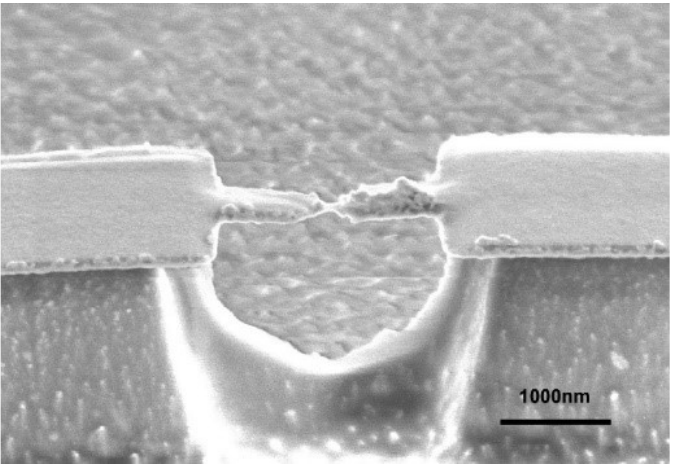
Figure 1. Scanning electron micrograph of a microfabricated mechanically controllable break junction (MCBJ) consisting of a free-standing Au junction on a polyimide-coated phosphor-bronze substrate. Scale bar denotes 1 μm.